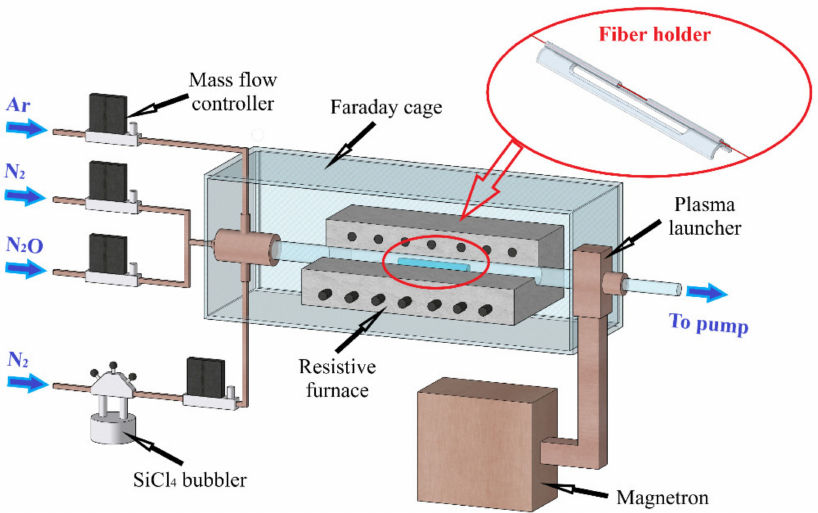
Figure 1. Schematic of the experimental setup for coating film deposition; inset—a model of the fiber